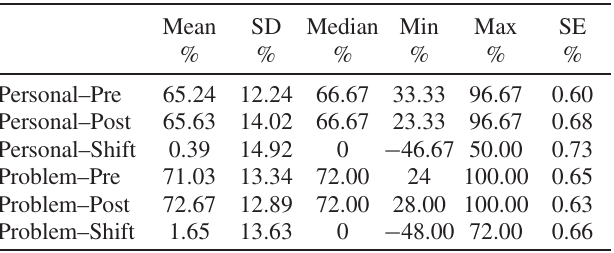
TABLE XV. Descriptive statistics of personal and problem factor scores and shifts from pre- and postresponses to proposed 11-item